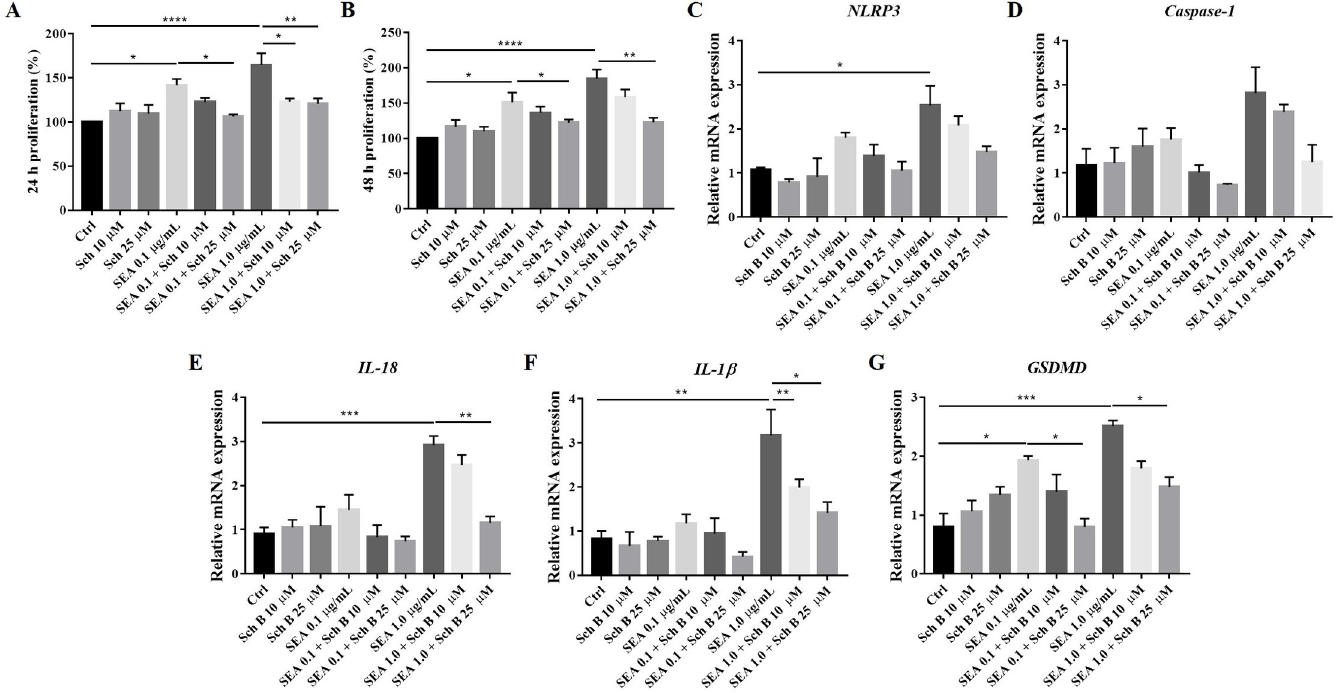
Fig 4. Proliferation and inflammasome activation in RAW264.7 cells stimulated by S . mansoni soluble egg antigens. RAW264.7 cells were treated with indicated concentration of soluble egg antigen (SEA) and Sch B. (A-B) 24- and 48- hour proliferation of RAW264.7 cells, measured by WST-1 assay. (C-G) mRNA expression of inflammasome component. All results are presented as the mean ± S.D. from three independent experiments. � P -value < 0.05, �� P -value < 0.01, ��� P -value < 0.001, and ���� P -value < 0.0001 compared between groups.